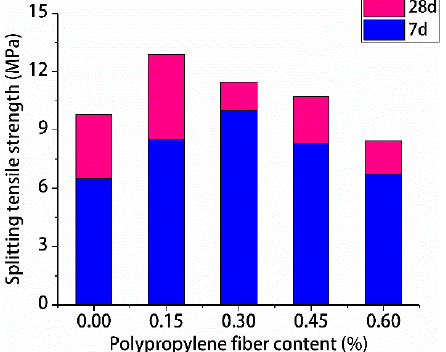
Figure 10. Test results for splitting tensile strength.